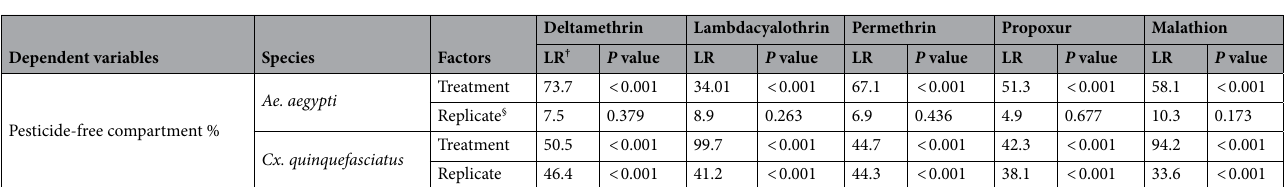
Table 2. Logistic regressions testing the effects of the 3 treatment groups and replicates on the proportion of females that rested in the compartment void of pesticide smell during the resting site choice assay. All dependent variables were treated as binomial variable. The Chi-square of Likelihood Ratio effect tests (LR) are presented with respective P values. § Replicate effects were nested within